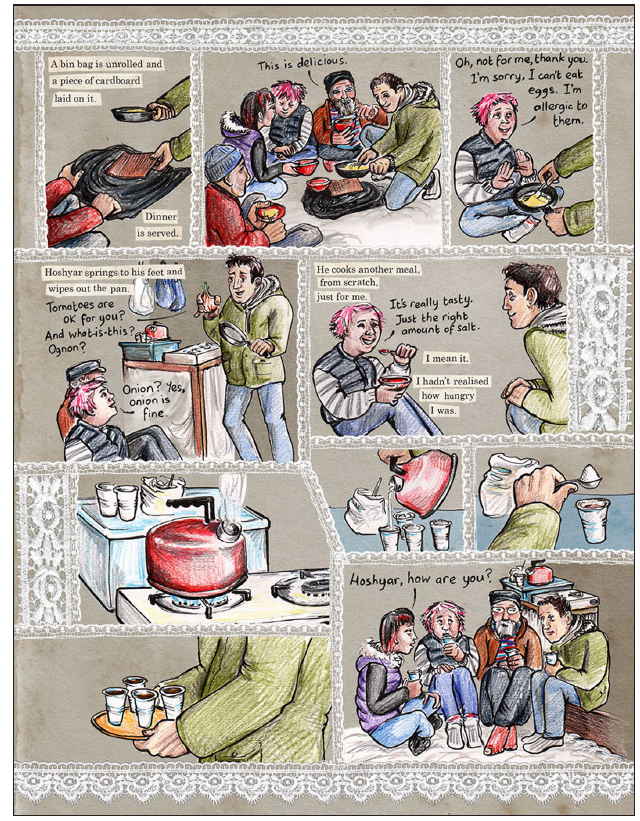
Figure 1: Kate Evans (2017) Threads from the Refugee Crisis (New York: Verso, 58). © Verso New York. Image presented with permission of Kate Evans and